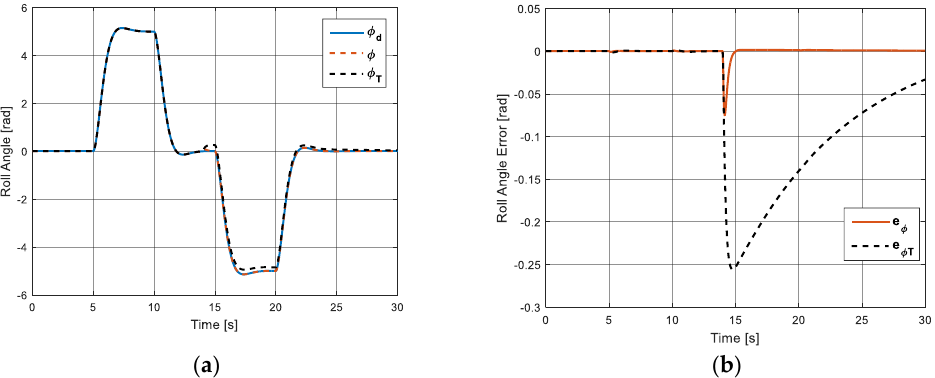
Figure 4. Comparison of tracking performance between normal adaptive sliding mode control (NASMC) and modified adaptive sliding mode control (MASMC) with 10% loss of control effectiveness (LoCE) in actuator 2: ( a ) Roll angle; ( b ) tracking error.